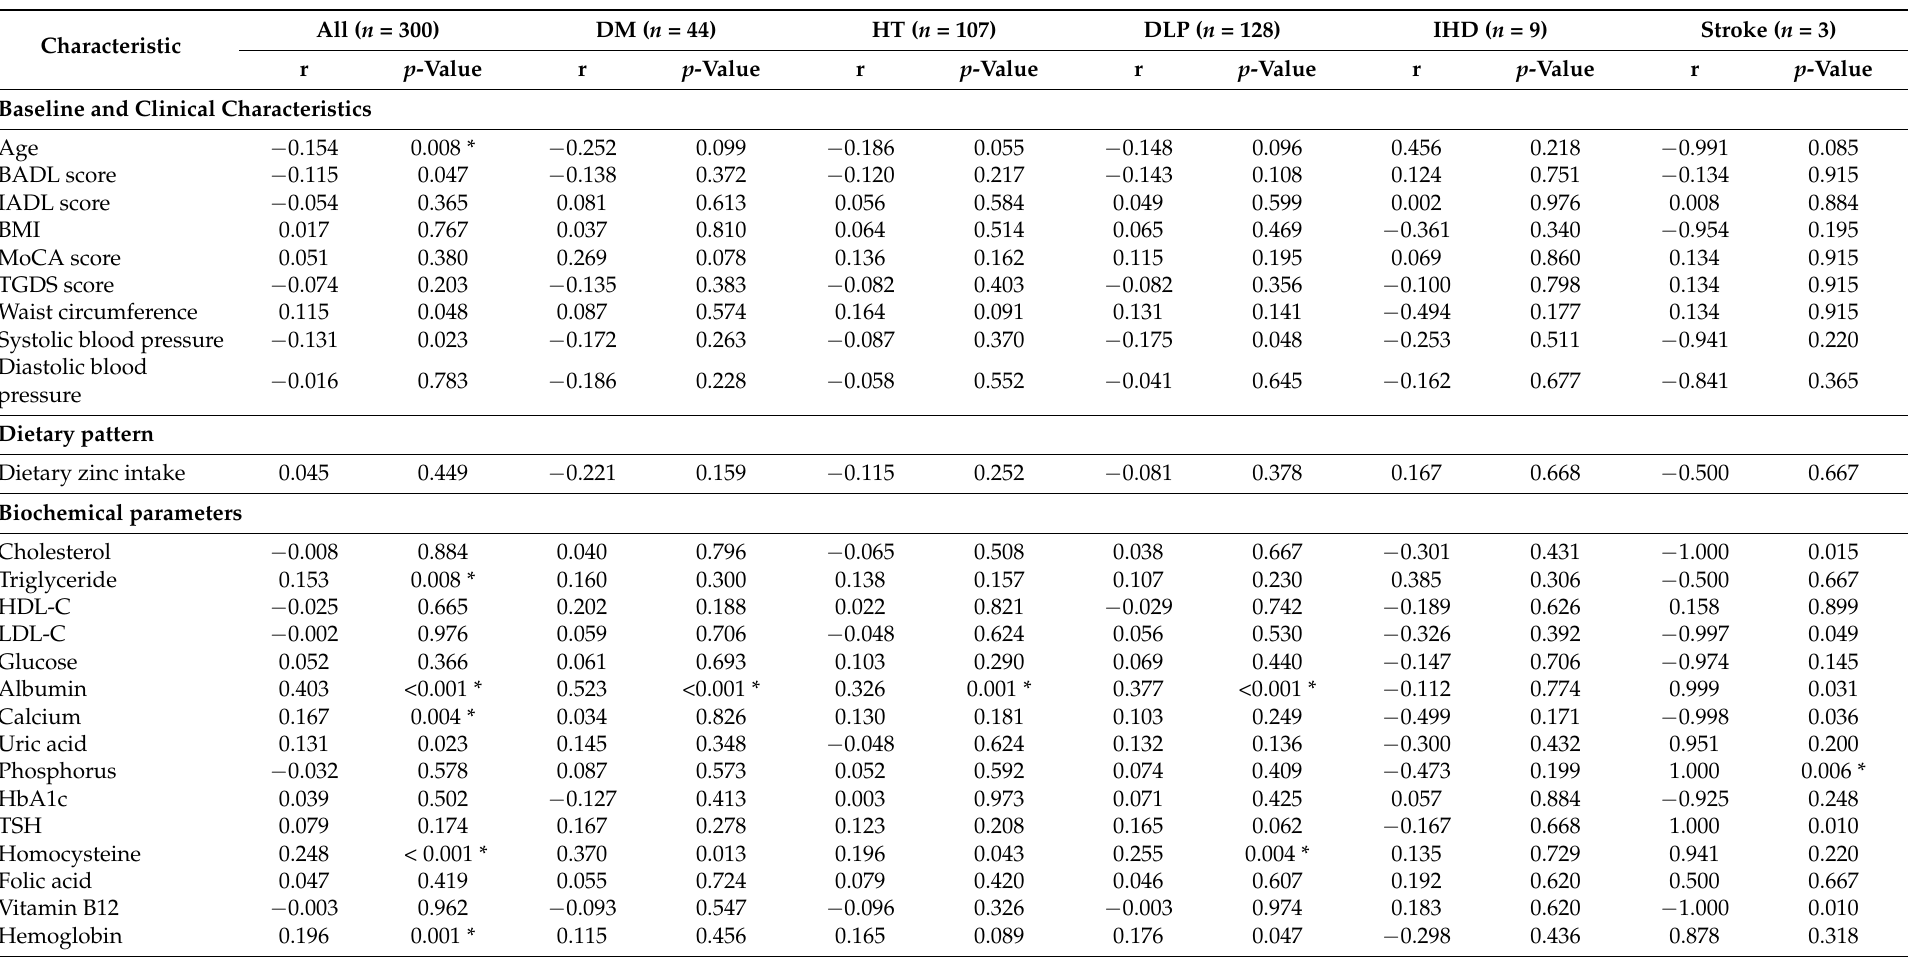
Table 3. Correlations between serum zinc levels and characteristics of the participants classified by